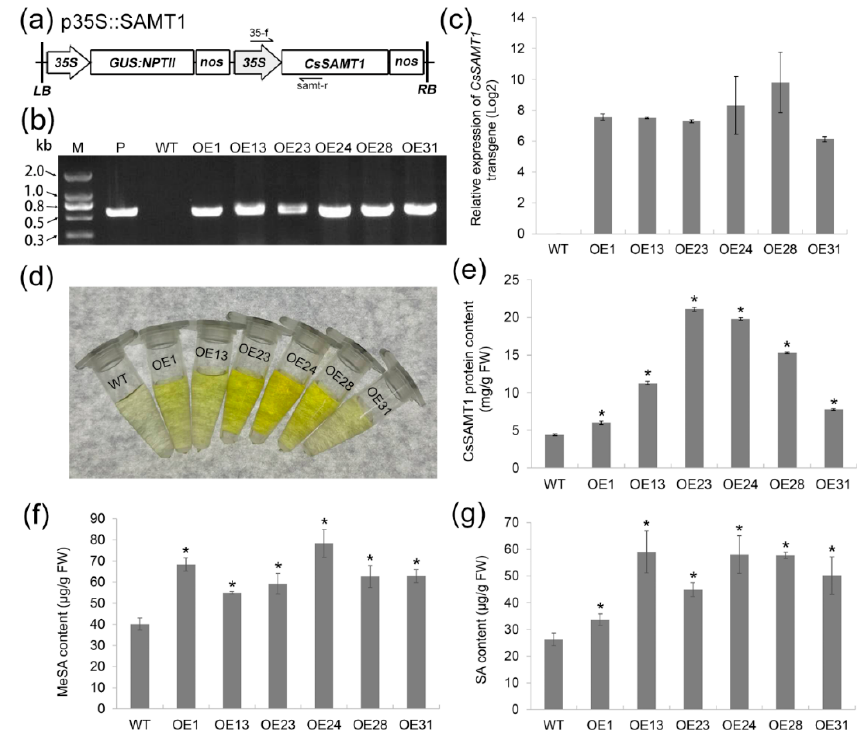
Figure 2. Production of transgenic Wanjincheng orange plants overexpressing CsSAMT1 . ( a ) T-DNA structure of the p35S::SAMT1 construct used in the citrus transformation. 35S , tobacco Cauliflower mosaic virus 35S promoter; GUS:NPTII , fusion of β -glucuronidase and neomycin phosphotransferase genes (for the screening of citrus transformants); nos , nos terminator; LB , left border; RB , right border. 35-f/samt-r primers for the identification of transgenic plants by PCR. ( b ) PCR confirmation of transgenic plants. Using 35-f/samt-r primers shown in ( a ), transgenic plants were confirmed by PCR. ( c ) Relative expression of CsSAMT1 transgene in transgenic plants. The citrus actin (XM_006464503.3) was used as the reference gene for transcript normalization. Compared to Wild type (WT) plants, the relative expression of CsSAMT1 in transgenic plants was determined using qRT-PCR. Log2 values of relative expression were presented here. ( d , e ) ELISA assay of SAMT protein levels in transgenic plants. Protein levels were calculated based on the weight of fresh leaves. ( f , g ) Determination of MeSA and SA contents in transgenic plants. SA and MeSA were extracted from fully matured leaves and were determined using the plant SA and MeSA ELISA kits. Vertical bars indicate the standard deviations of the means of six tests. * represent significant differences from WT controls based on a Tukey’s test ( p < 0.05). M, DNA marker; P, p35S::SAMT1 plasmid; WT, wild type; OE#, transgenic plants; SA, salicylic acid; MeSA, methyl